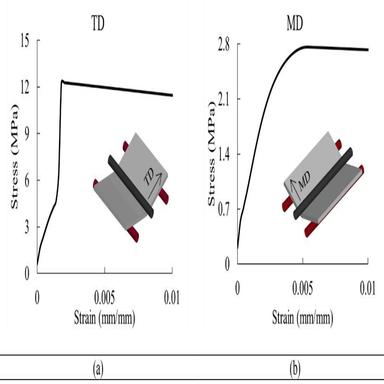
Calibrated tension stress-strain curves, the output of the analysis, in (a) TD (Transverse Direction) and (b) MD (Material Direction). These curves were calibrated using three-point bending data in longitudinal and transverse directions, respectively.